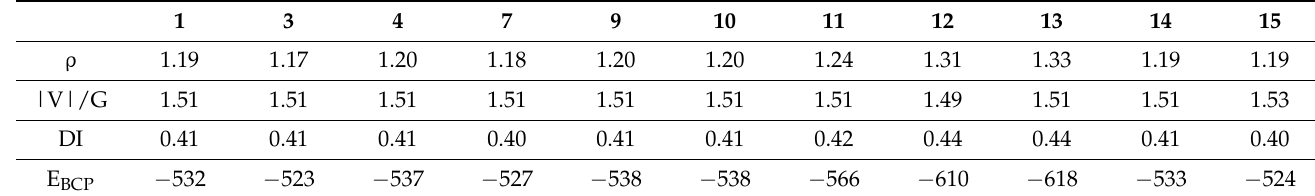
Table 3. Properties of the electron density at the B-N bond critical point (BCP #1, see Figure S7) of the selected aromatic azaborines. ρ = electron density, |V|/G = ratio between potential energy density and kinetic energy density, DI = delocalization index, E BCP = total energy at the BCP.